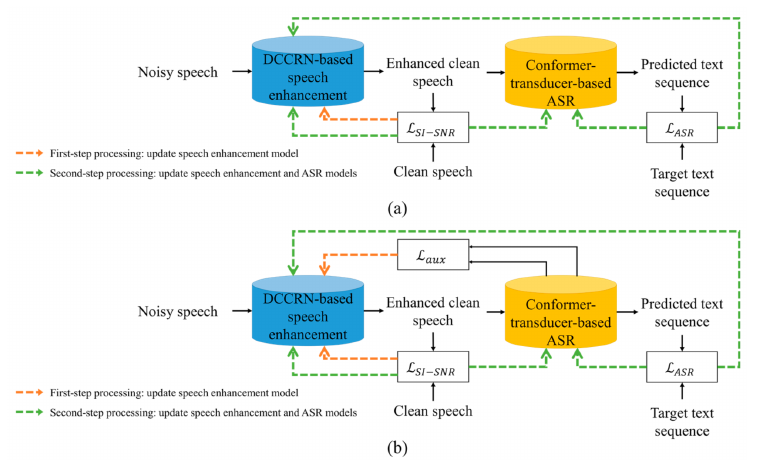
Figure 6. Block diagram comparison of the joint optimization approaches between ( a ) the conven- tional joint optimization [38] and ( b ) the proposed two-step joint optimization, applied to the noise- robust ASR pipeline composed of DCCRN-based speech enhancement and conformer-transducer- based ASR